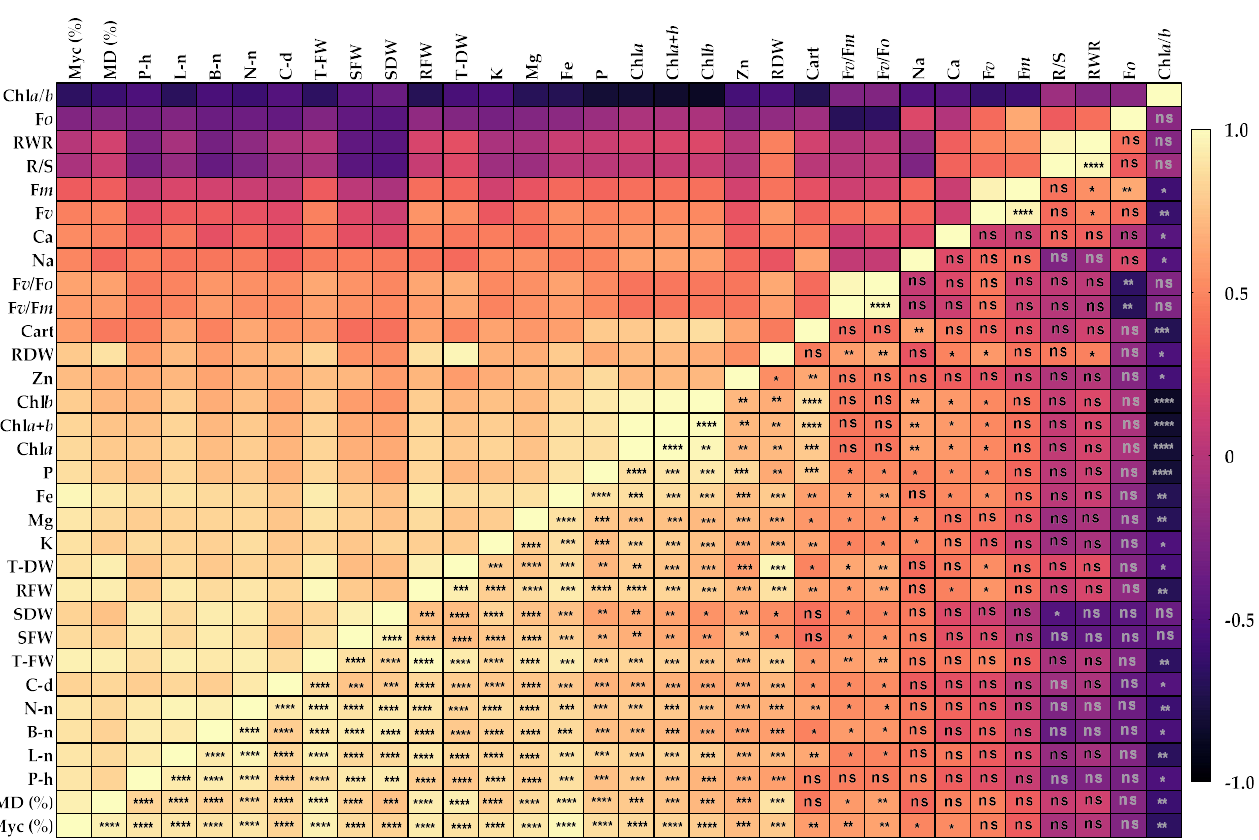
Figure 4. Pearson correlation matrix representing by heatmap illustration of all measured parameters. Each box’s color intensity is directly commensurate with the Pearson’s r correlation coefficient-value between every two variables in row and column. R value ranges between −1 and 1 as presented in the heatmap legend. ns, *, **, ***, **** indicate no significant correlation, significant correlation at p < 0.05, p < 0.01, p < 0.001 and p < 0.0001 confidence level, respectively. Abbreviations for all parameters are noted above in Figure 3.